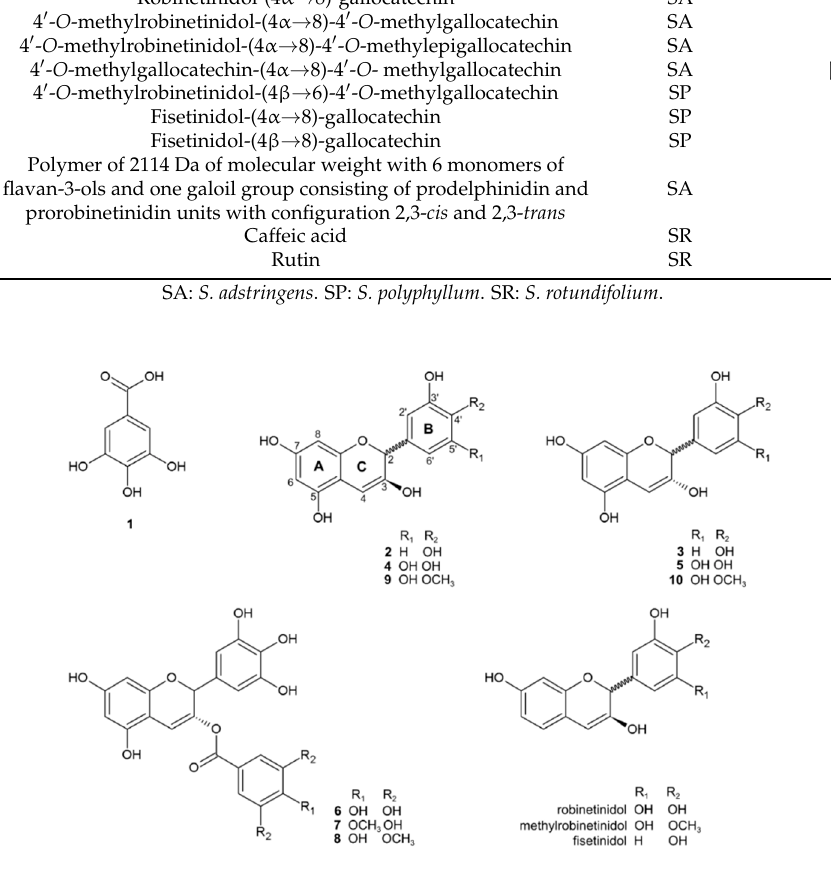
Figure 2. General chemical structure of gallic acid and proanthocyanidins identified in the bark of Stryphnodendron spp. known as “barbatimão”. Numbers indicate the respective molecule in Table 2, with respective substituent (R). Dimers and the polymer identified are repetition of these monomers according to their names in the corresponding carbon positions.